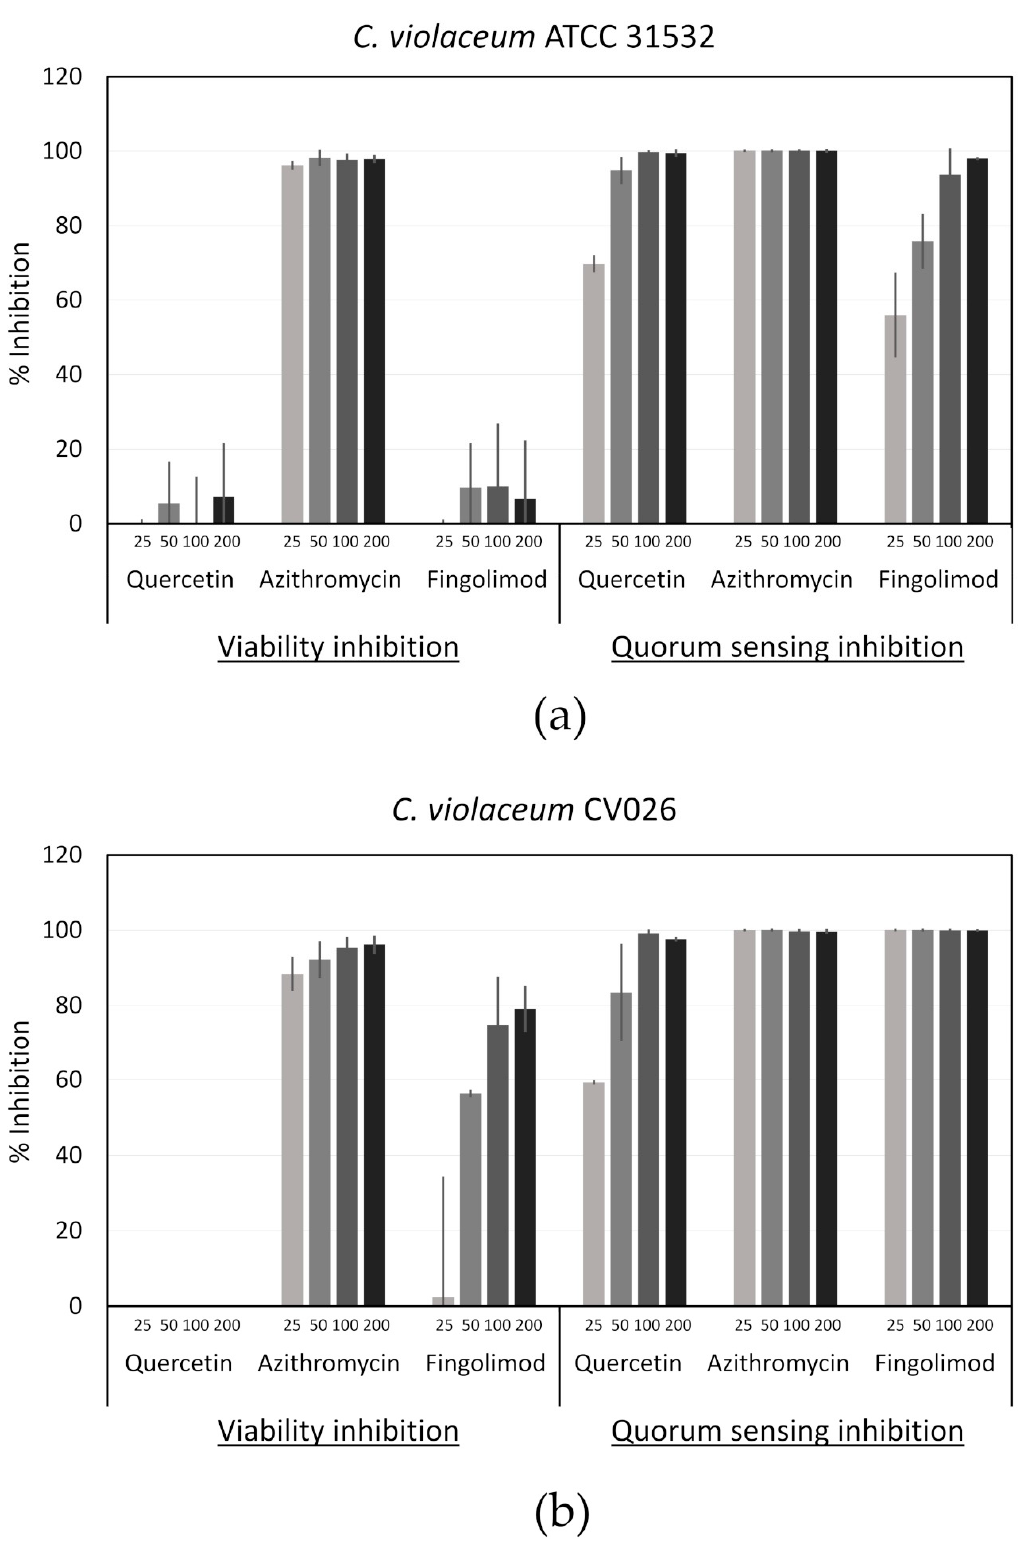
Figure 8. Viability and quorum sensing (QS) inhibition of C. violaceum ( a ) ATCC 31532 and ( b ) CV026 by fingolimod, quercetin (QS inhibitor (QSI) control) and azithromycin (bactericidal control). Concentrations are in µM and the results are expressed as percentages of inhibition in comparison with untreated controls. Results are from two different experiments performed with two technical replicates for each condition ± SD.